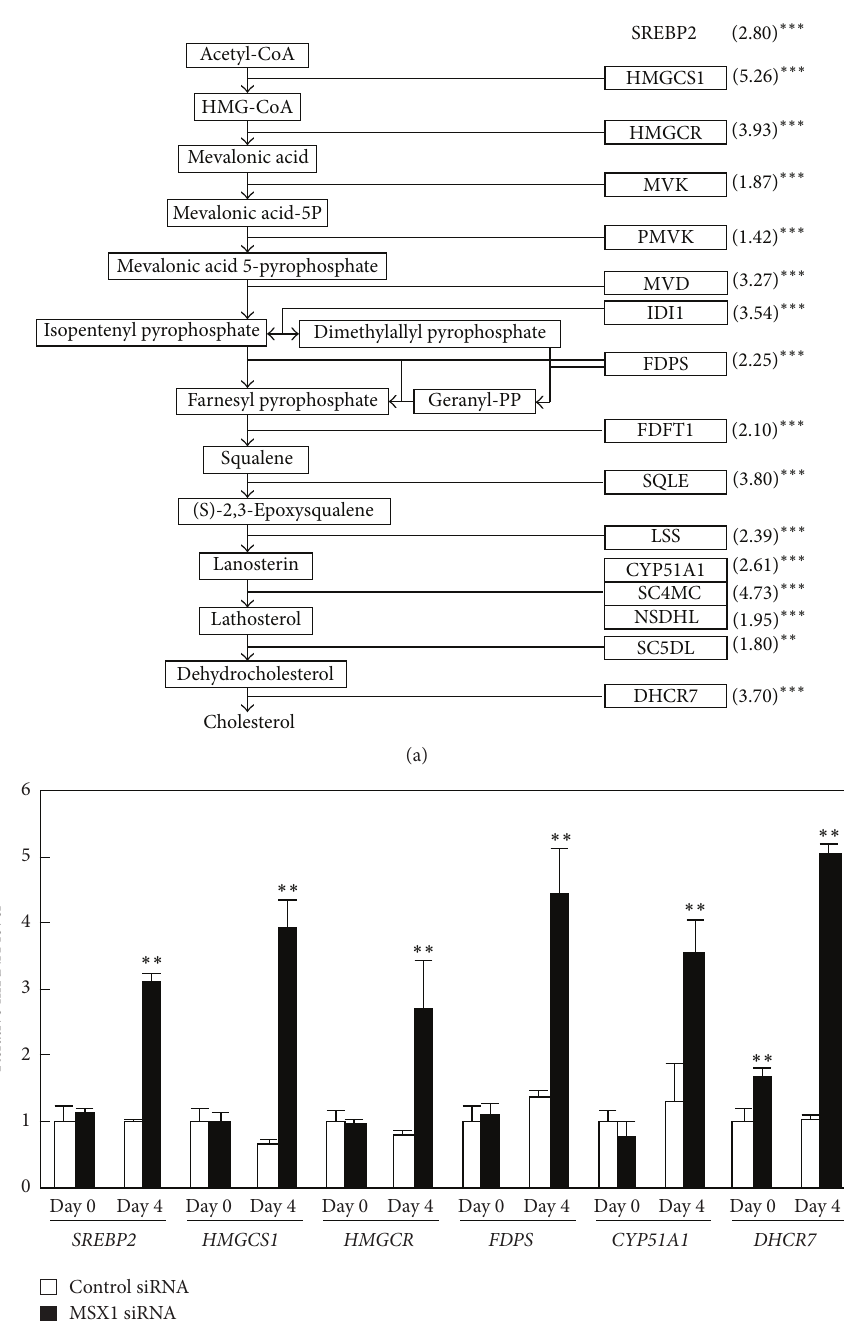
Figure 5: Effects of MSX1 knockdown on the expression of cholesterol synthesis-related genes, which are direct targets for SREBP2, in hDPSCs. (a) The cholesterol biosynthesis pathway is shown and the bold frames indicate target genes for the master transcriptional factor SREBP2. Microarray analysis indicates all genes involved in cholesterol synthesis are upregulated by MSX1 knockdown. The numbers in brackets represent the fold changes in gene expression in MSX1 -knockdown cells as compared with the control cells. (b) The mRNA levels of genes relevant to cholesterol synthesis, including SREBP2 , HMGCS1 , HMGCR , FDPS , CYP51A1 , and DHCR7 , were quantified by RT-qPCR analysis. Values are averages ± SD for three cultures. ∗∗ 𝑃 < 0.01 ; ∗∗∗ 𝑃 < 0.001